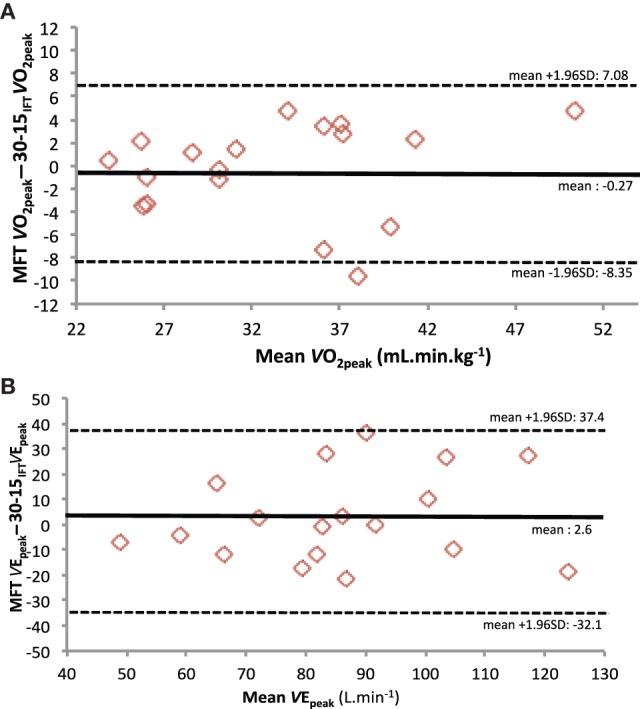
Analysis of the individual difference by Bland-Altman method between MFT and 30-15IFT test and (A) peak oxygen consumption (VO2peak) and (B) peak ventilation (VEpeak).